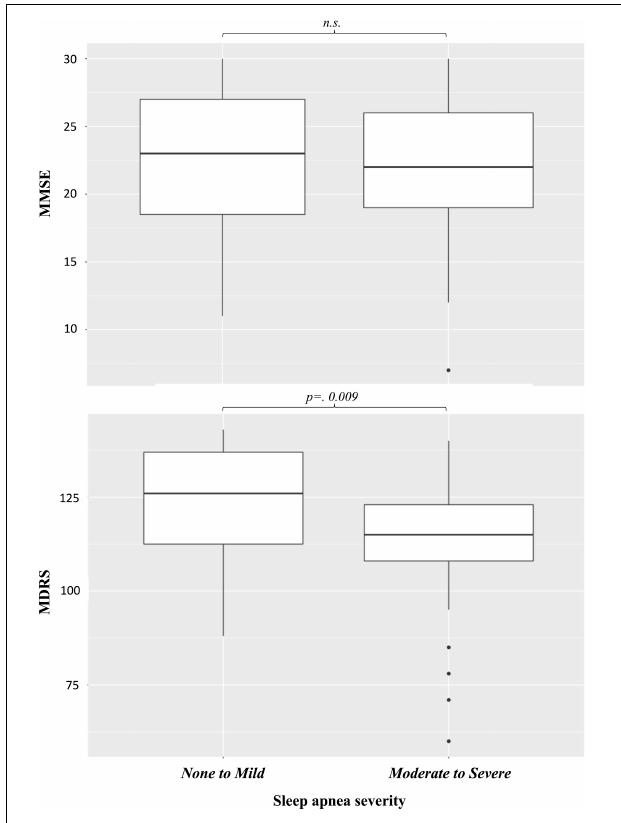
FIGURE 2 | Effects of sleep apnea on cognitive